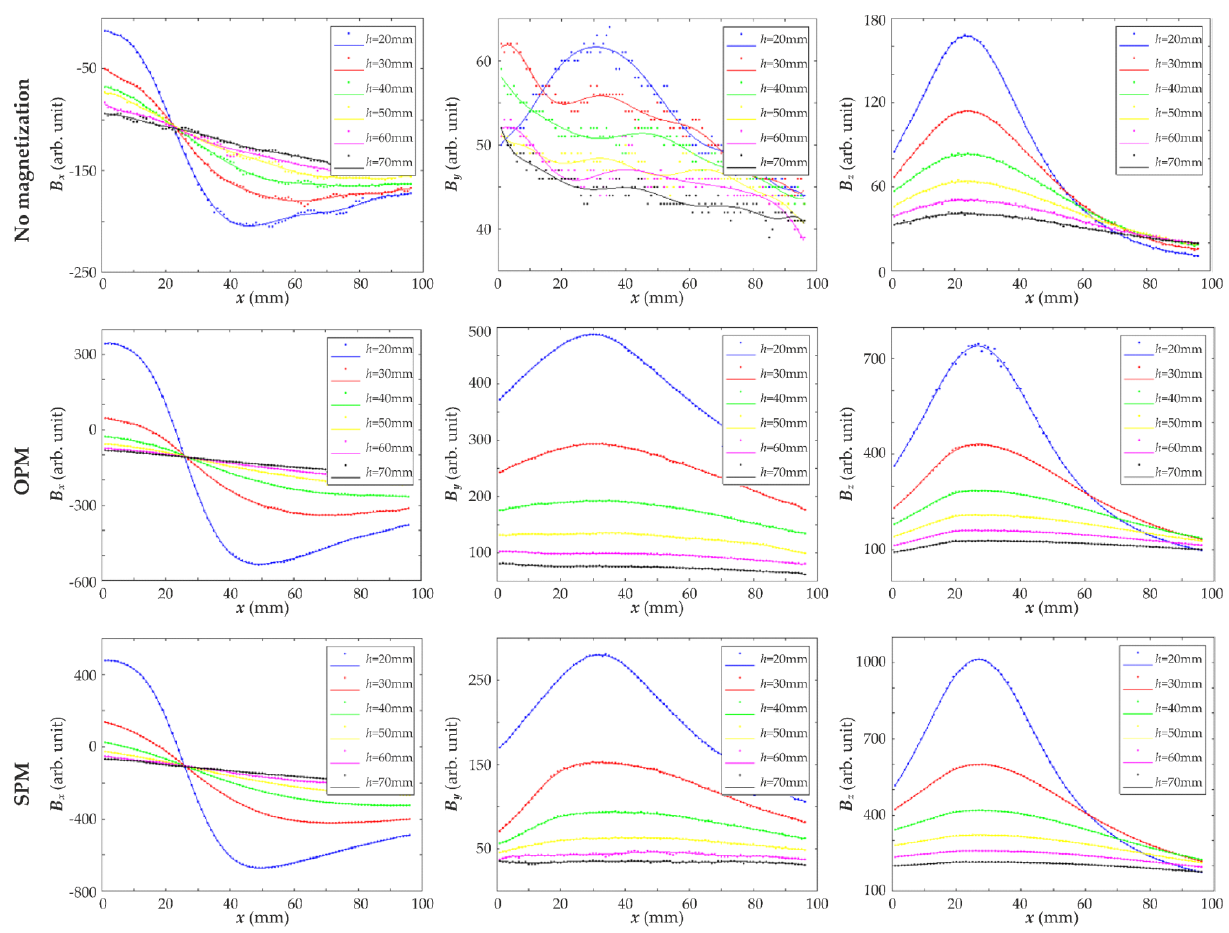
Figure 17. Plots of the magnetic field components as a function of sensor position x (mm) which are showing the influence of the concrete cover thickness h .